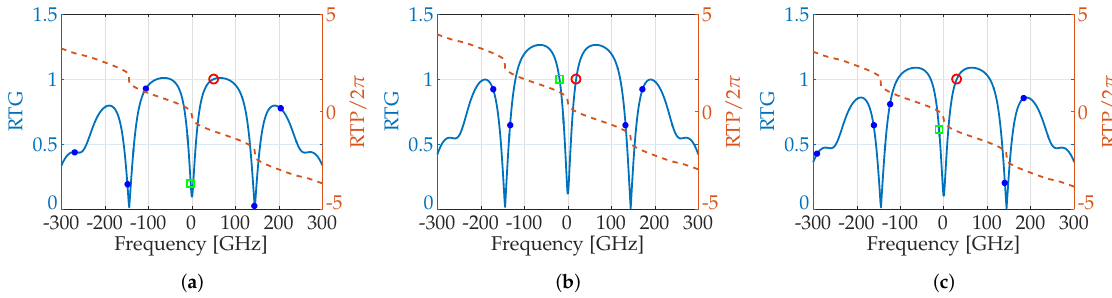
Figure 2. Round trip gain (RTG) (continuous blue line) and phase (RTP) (dashed red line) functions plots at threshold around the Bragg frequency for three different additional phase shifts φ S in the slave laser cavity. The lasing mode is indicated by the red circle, the closest non-lasing mode by the green square marker and the other non-lasing modes by the blue dots. L gr , M = 181µm, L M = L S = 250µm, L gr , C = 65µm, L gr , S = 70µm, κ = 100cm − 1 . ( a ) φ S = 0 and f PPR = 47GHz, ( b ) φ S = π and f PPR = 35GHz and ( c ) φ S = π /2 and f PPR = 38GHz.